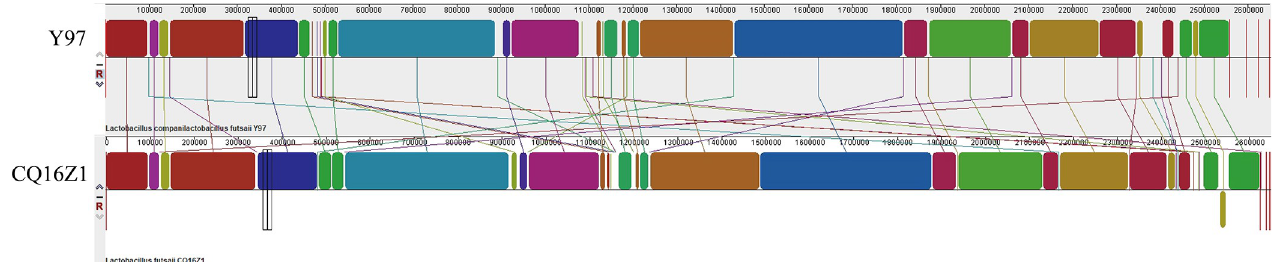
Fig 2. Mauve alignment results of CQ16Z1 and Y97. CQ16Z1 represented Companilactobacillus futsaii subsp. chongqingii CQ16Z1, and Y97 represented Companilactobacillus futsaii subsp. futsaii YM0097.